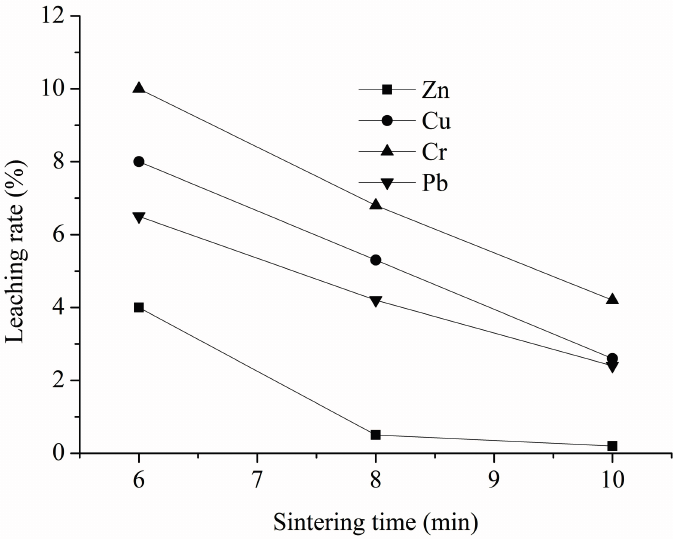
Figure 6. Effect of sintering time on the leaching rate of heavy